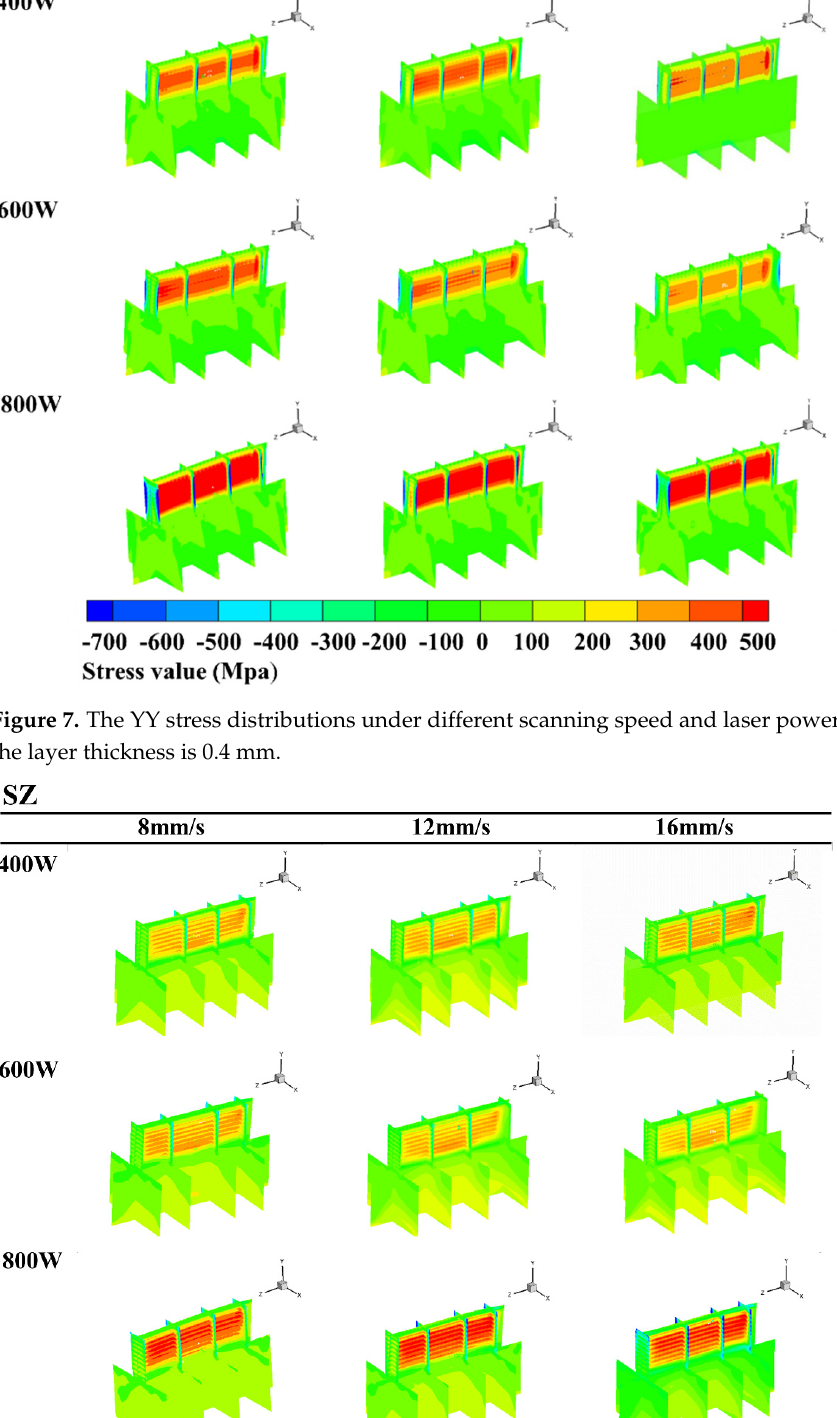
Figure 6. The XX stress distributions under different scanning speed and laser power values when the layer thickness is 0.4 mm.